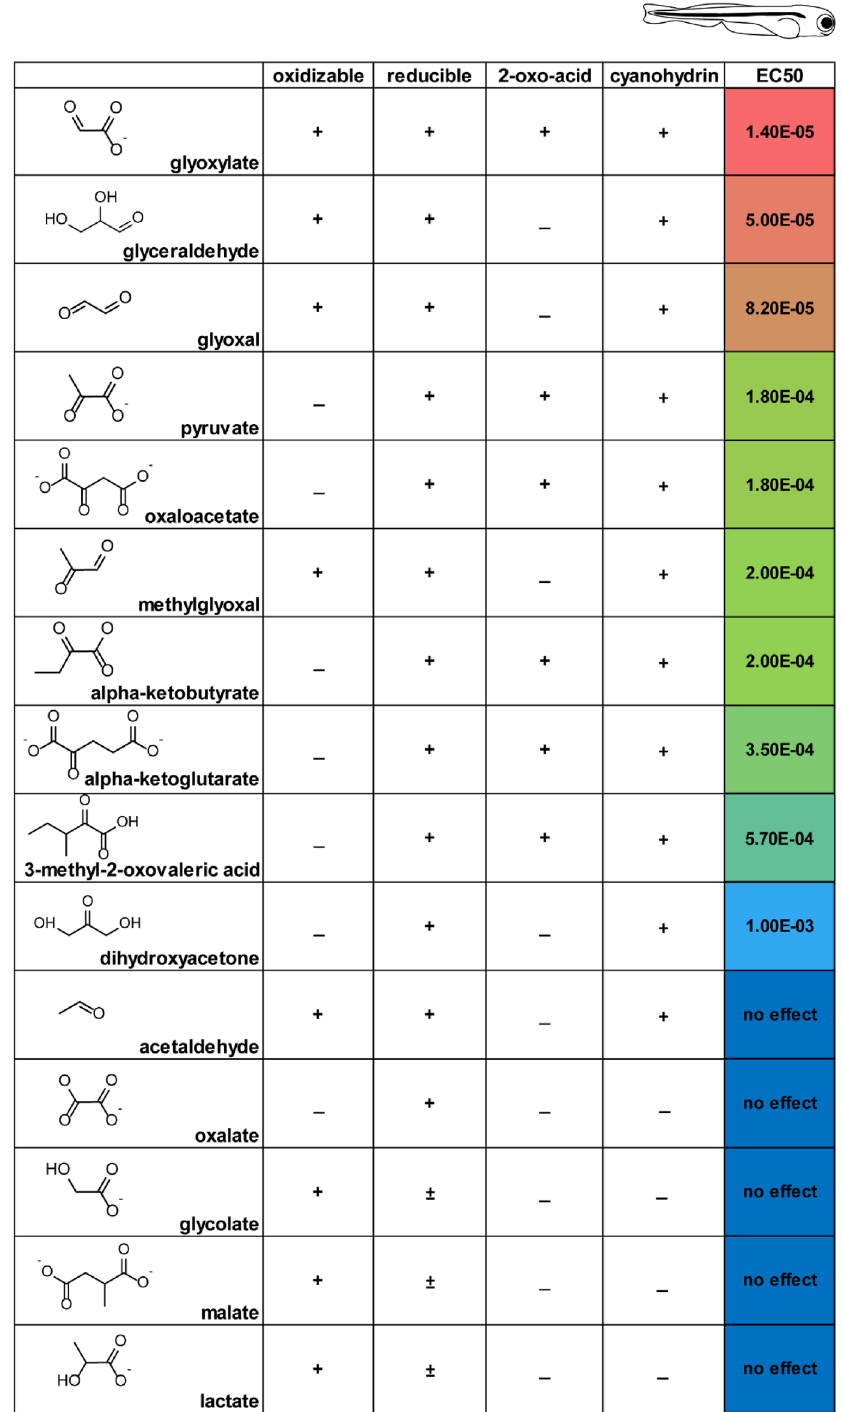
Table 1. Properties of metabolites with structural similarities to glyoxylate. EC50 values were obtained from data presented in Fig.